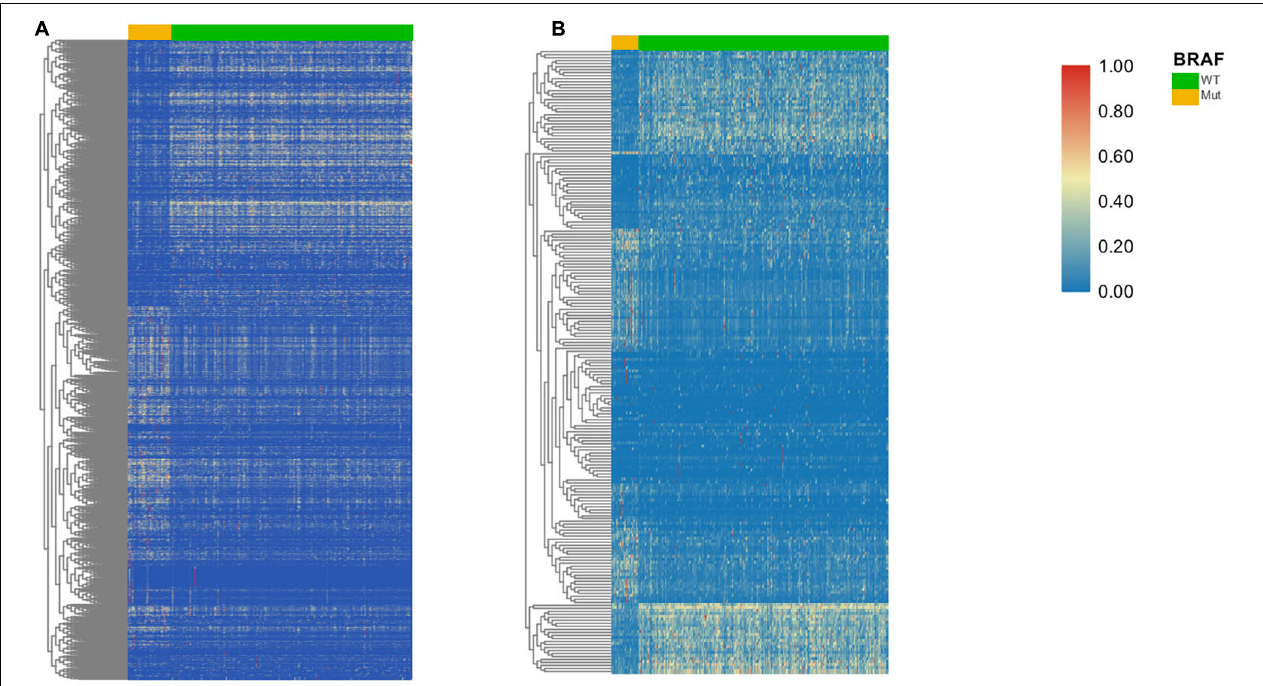
FIGURE 3 | Heatmaps of DEGs in the TCGA (A) and GEO dataset (B)